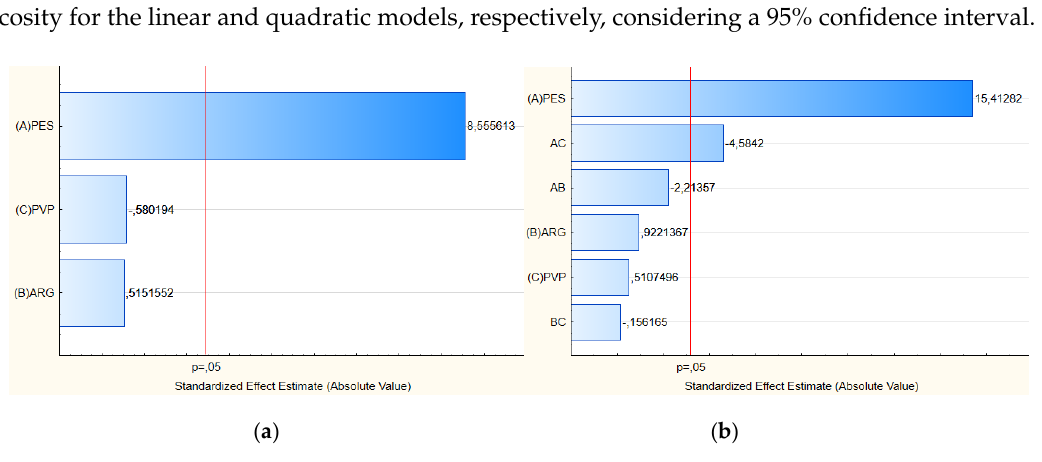
Figure 4. Pareto chart for the models obtained by the mixed design for viscosity: ( a ) linear and ( b ) quadratic.